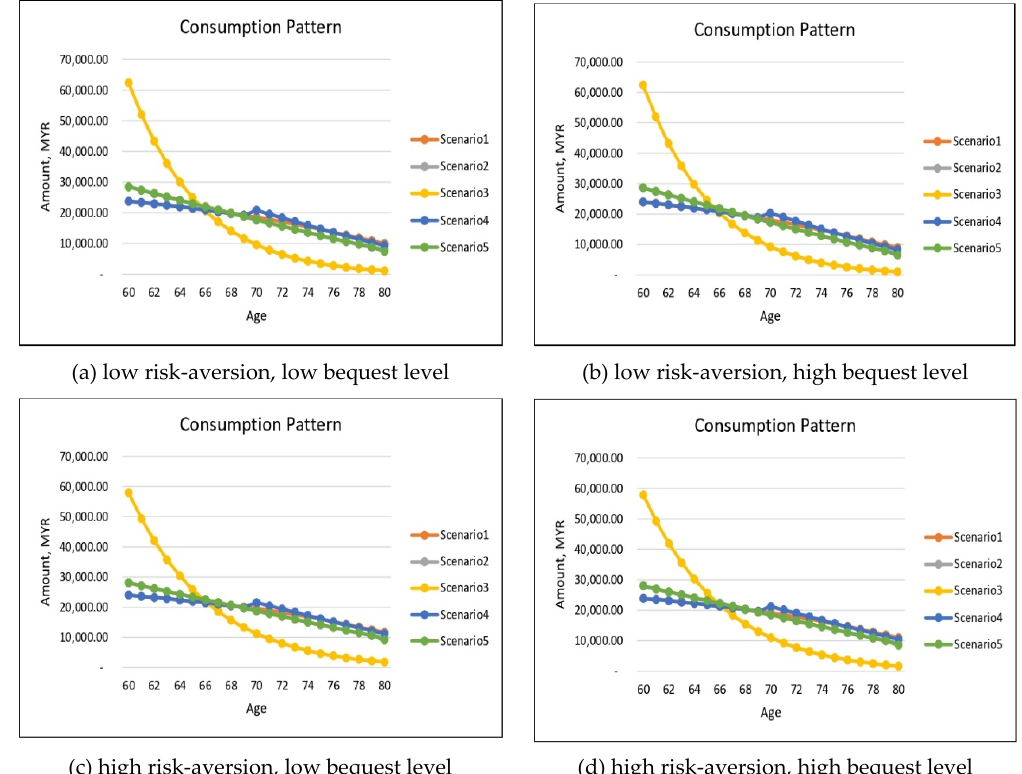
Figure 9. Optimal Consumption Pattern for Females (Health-Dependent